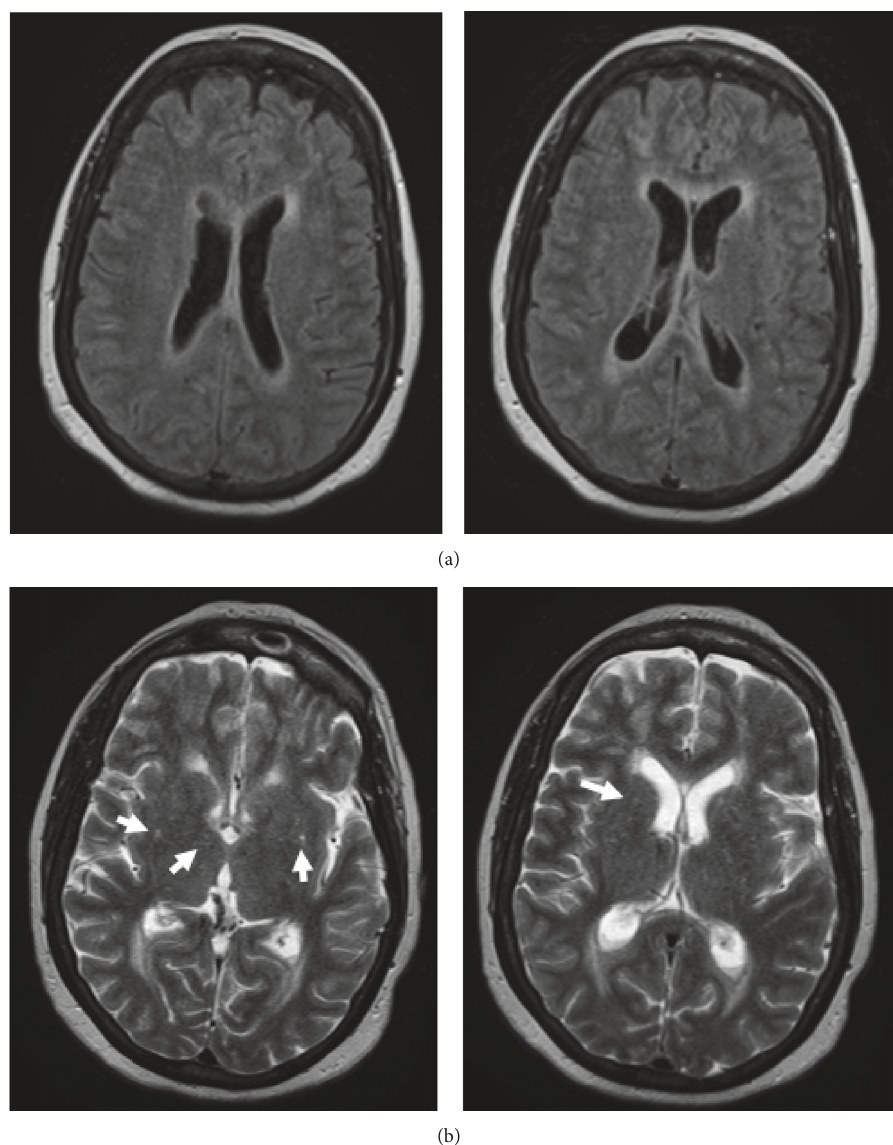
Figure 1: MRI brain taken on hospital day 3. (a) FLAIR enhancement of the ventricles and fluid levels within the posterior lateral ventricles, consistent with ventriculitis. (b) T2 enhanced images showing acute infarcts in the periventricular areas